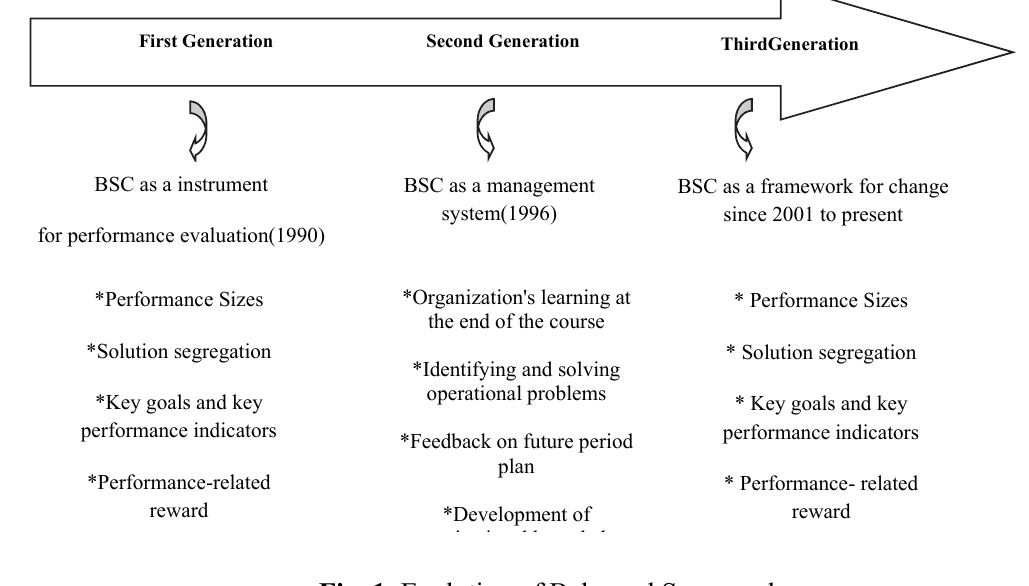
Fig. 1. Evolution of Balanced